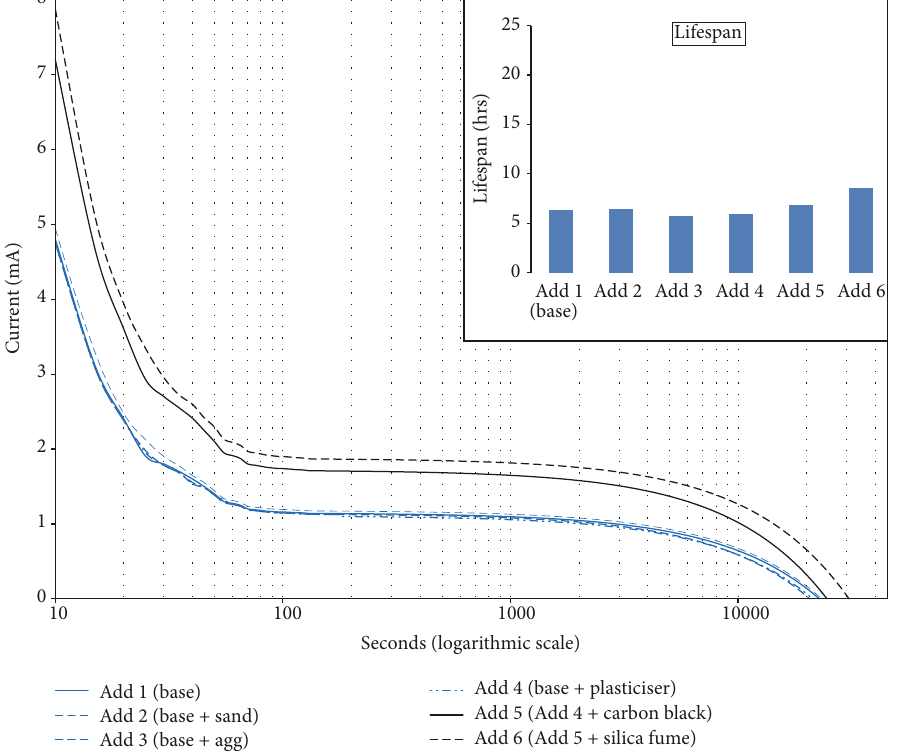
Figure 9: Current discharge curves across a 10 Ω resistor for different